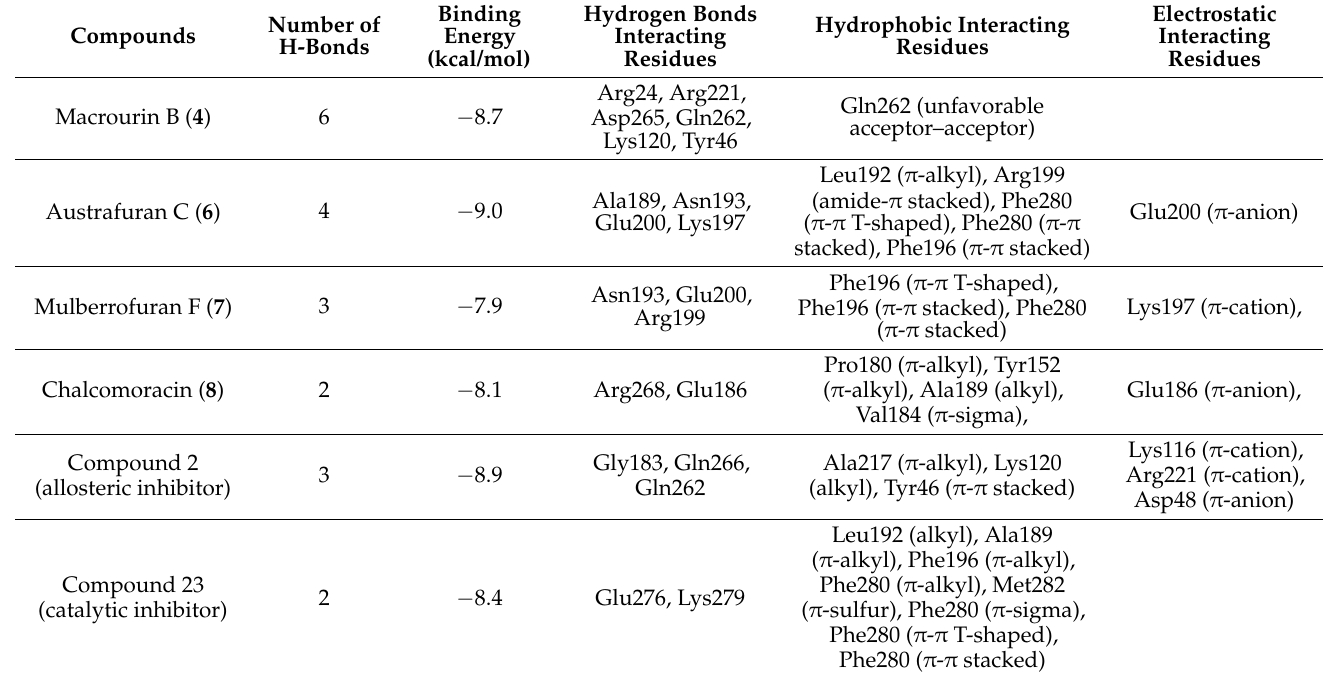
Table 6. Binding site residues and docking scores of compounds in the PTP1B using the AutoDock Vina 4.2